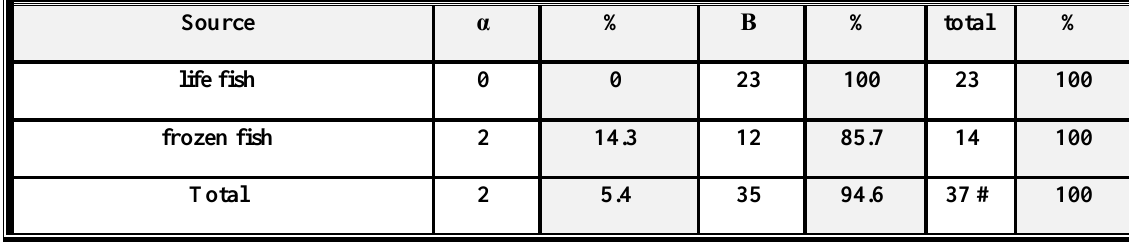
Table 1: Hemolytic activity of Aeromonas hydrophila isolated from fish samples Source